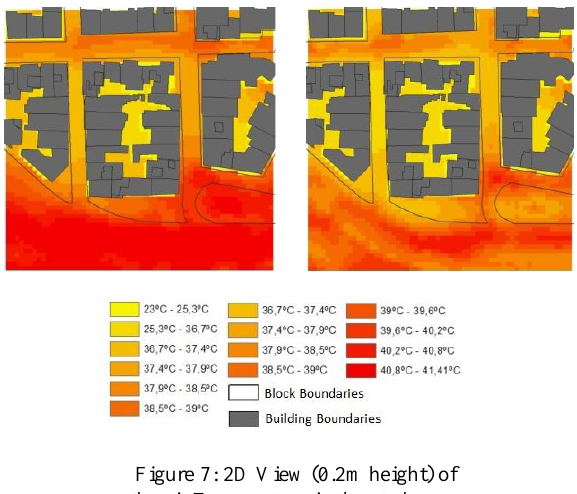
Figure 7: 2D View (0.2m height) of